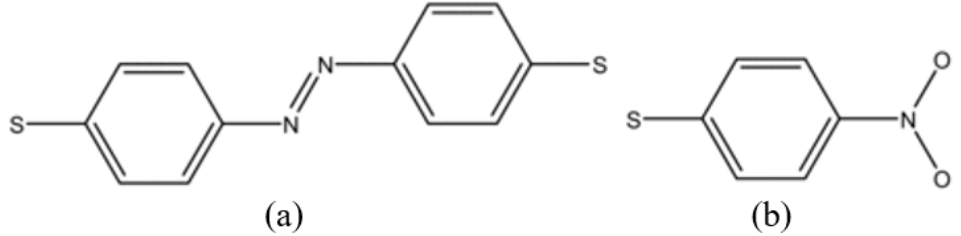
Figure 1. Chemical structures of ( a ) 4,4 (cid:48) -dimercaptoazobenzene (DMAB), and ( b ) 4-nitrobenzenethiol (4NBT) [28].